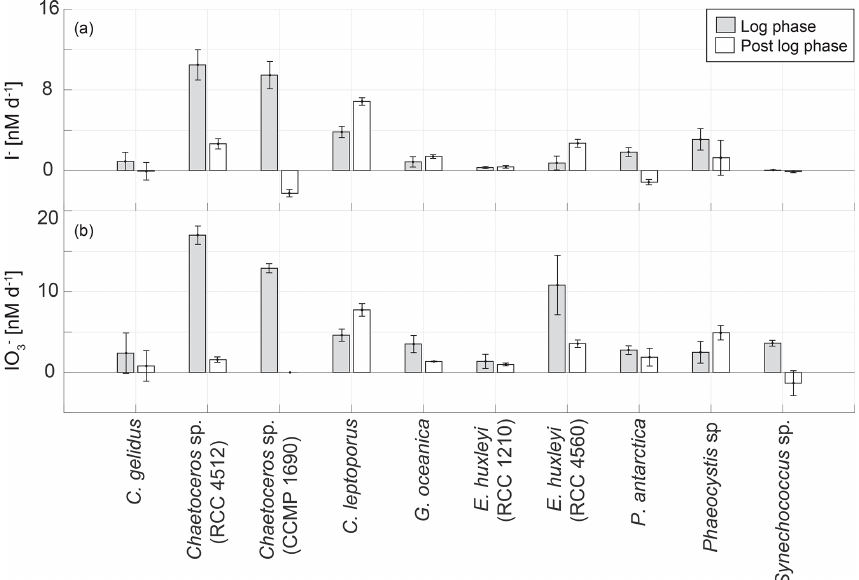
Figure 7. Comparison of the average net change in (a) I − and (b) IO − (white bar) stages of growth in 10 marine phytoplankton cultures averaged over the length of the respective growth phase. Error bars show the standard deviation from three replicate